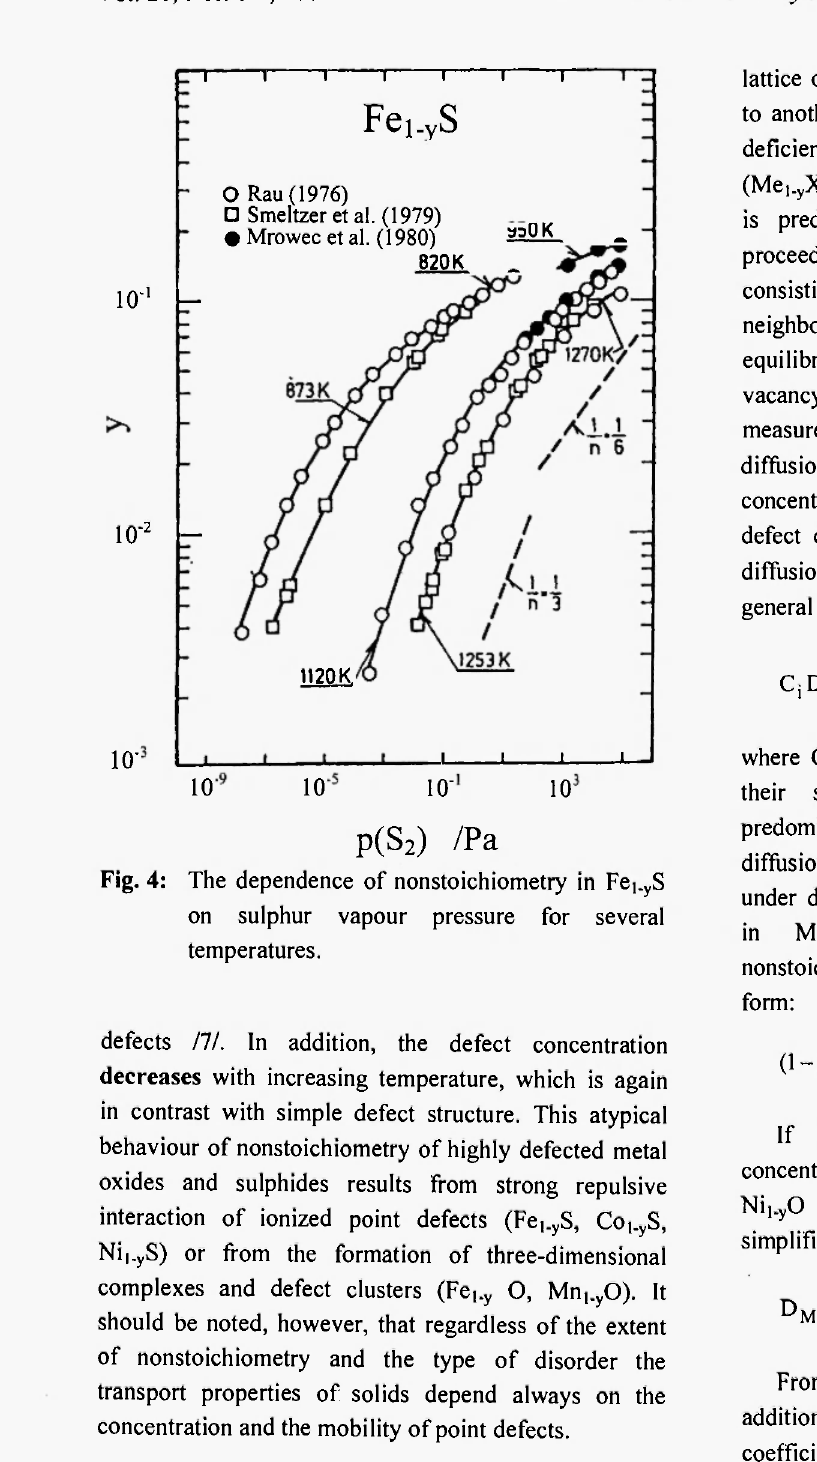
Fig. 4: The dependence of nonstoichiometry in Fe^yS on sulphur vapour pressure for several